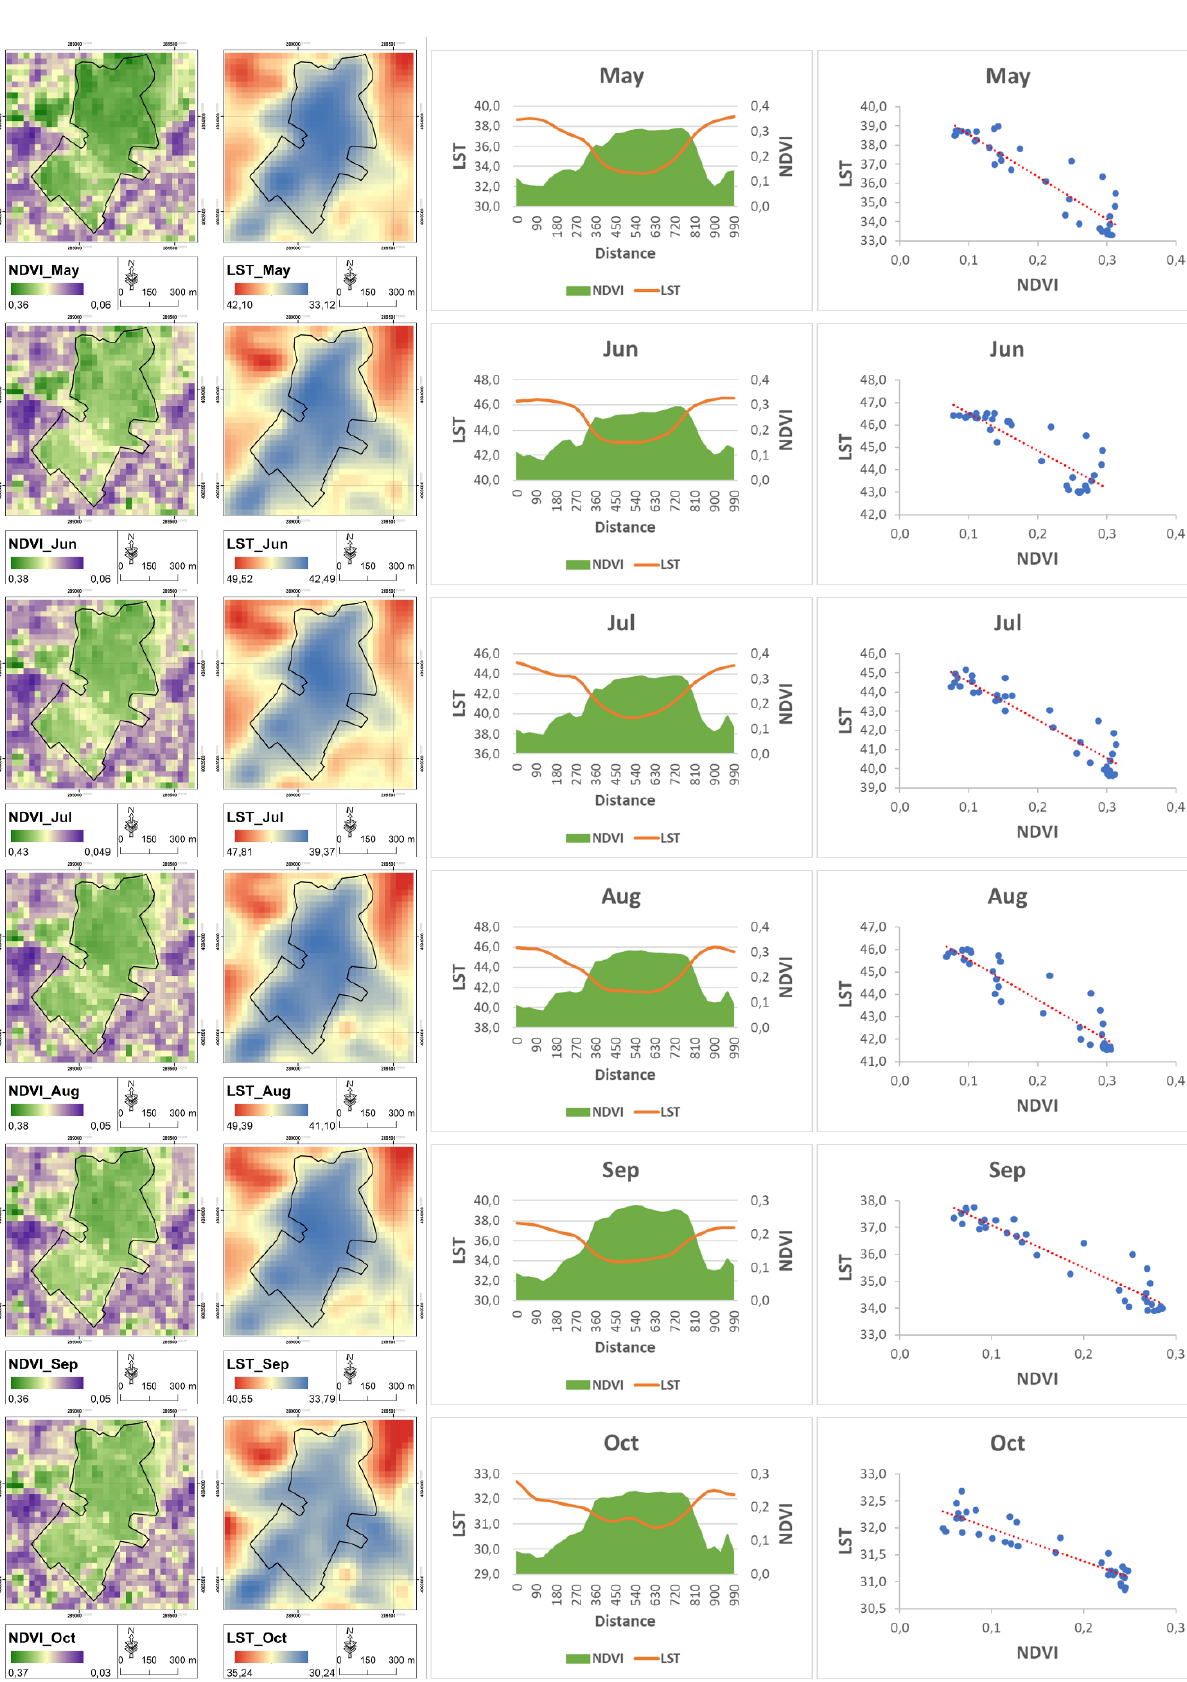
Figure 3 . Monthly maps and graphs of the NDVI and LST for the Hayat Park and Kent Forest sample